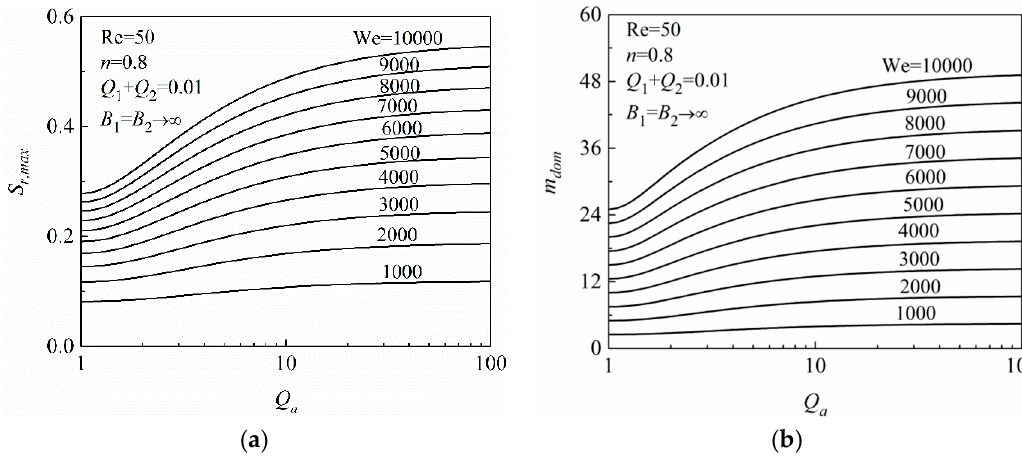
Figure 7. Effect of the aerodynamic asymmetry on jet instability at different Weber number with para-sinuous mode: ( a ) dimensionless maximum growth rate; ( b ) dimensionless dominate wave number.